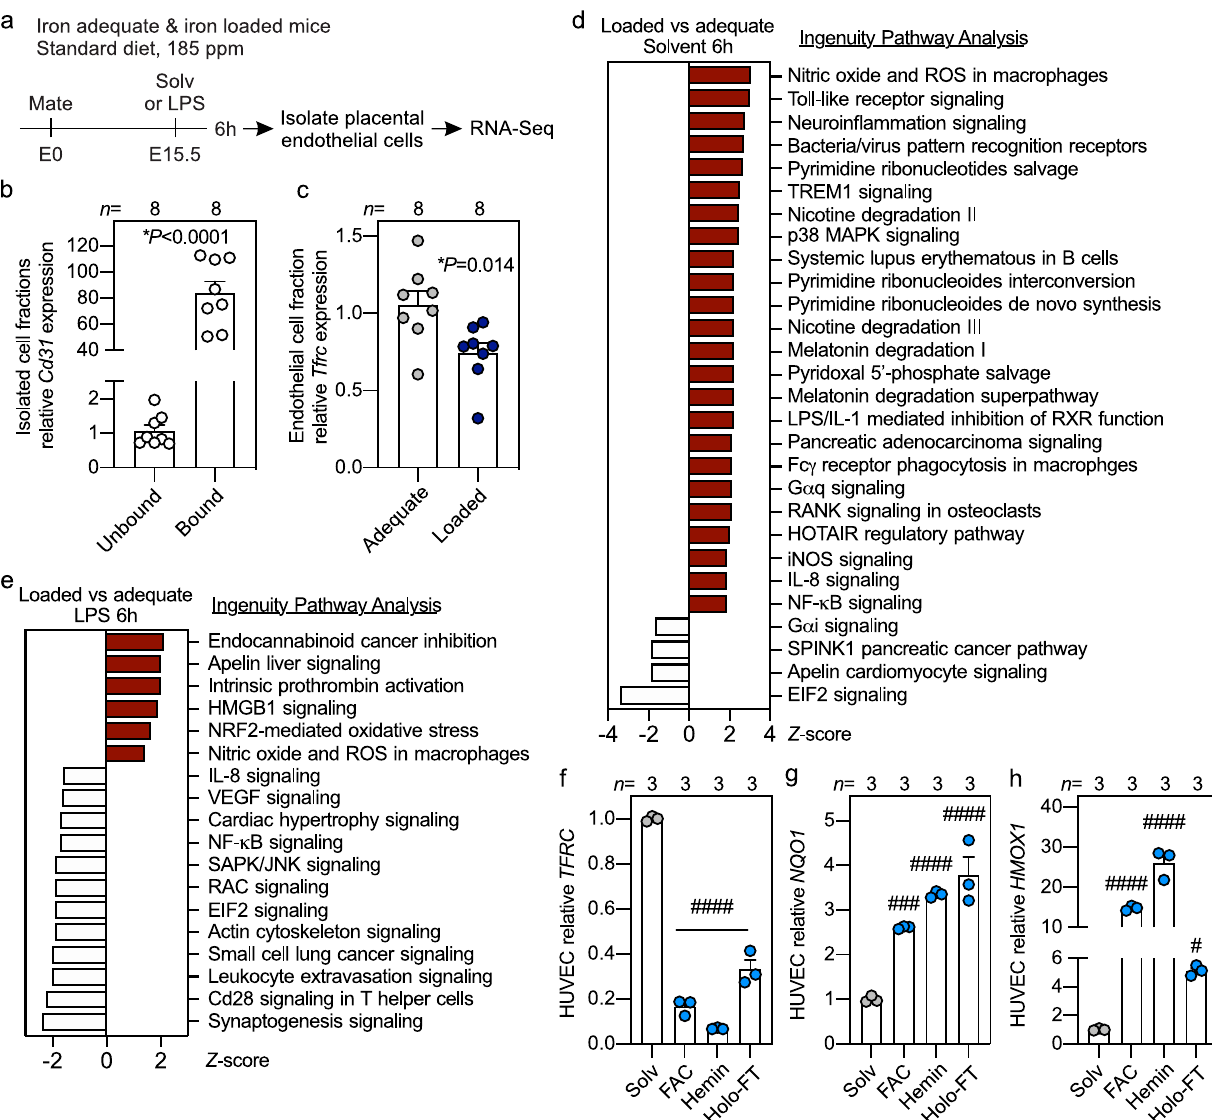
Fig. 4 Maternal iron loading promotes oxidative stress in placental endothelial cells. a Iron-adequate and iron-loaded dams were treated with solvent or LPS (0.5 µ g/g) on E15.5 for 6 h. Placentas from solvent and LPS-treated mice were collected for endothelial cell isolation by magnetic separation using Cd31 beads and total RNA was analyzed by RNA-Seq. b Cd31 expression relative to Rpl4 in the Cd31-unbound (non-endothelial cells) and Cd31-bound (endothelial cells) fractions. c Endothelial cell expression of iron importer Tfrc relative to Rpl4 from iron-adequate (light gray circles) and iron-loaded (dark blue circles) placentas. b , c Placenta cells isolated from n = 8 dams. d , e RNA-Seq Ingenuity Pathway Analysis of signi fi cantly downregulated (white bars) and enriched (red bars) genes ( Z -score < and > than ±1.5) from placental endothelial cells comparing hepcidin KO and WT mice after d solvent and e LPS injection. f – h Primary HUVECs were treated with solvent (gray circles), or different forms of iron (light blue circles) including ferric ammonium citrate (100 µ M, FAC), hemin (20 µ M), or holo-ferritin (Ft, 2 mg/ml) for 40 h and analyzed for f TFRC g NQO1 and h HMOX1 expression. n = 3 independent experiments. b , c , f – h Error bars represent mean ± s.e.m. Statistical differences were determined by two-tailed Mann – Whitney U , two-tailed Student ’ s t -test (denoted by *, P -values are indicated in each fi gure panel), or one-way ANOVA followed by Holm-Sidak method for multiple comparisons (denoted by # P < 0.05, ### P < 0.001, #### P < 0.0001). Source data are provided as a Source data fi